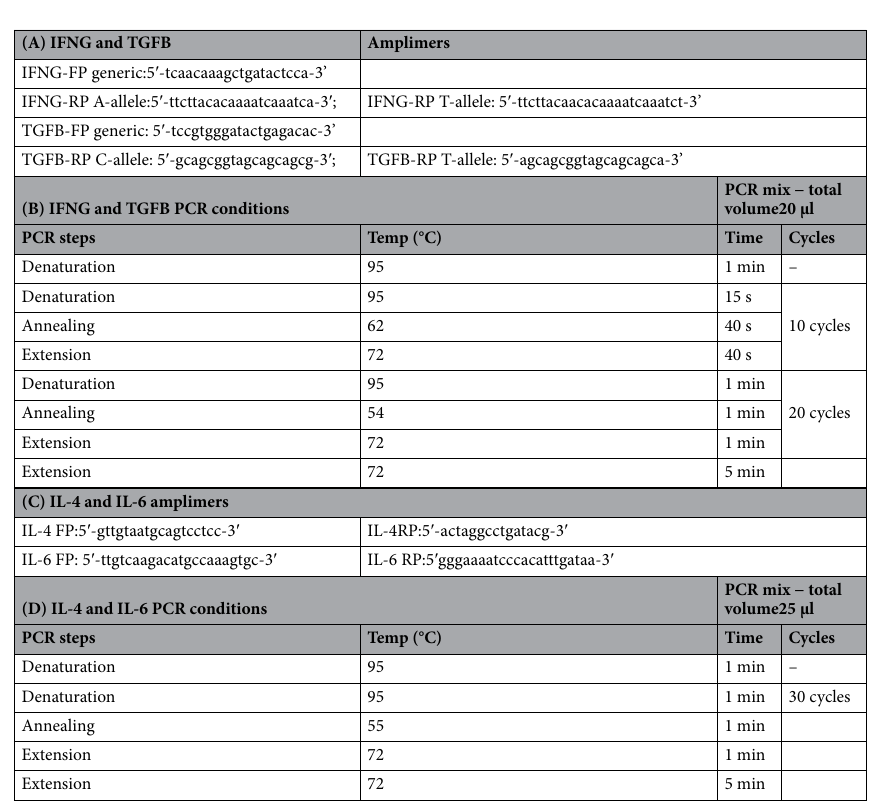
Table 2. Amplimers and PCR conditions. Digestion of IL4 done by BSmFI 65 °C 15 min 0.1 µl of RE and 1 µl cutting buffer for 10 µl PCR sample. Digestion of IL6 done by NIaIII 37 °C 15 min 0.02 µl of RE and 1 µl cutting buffer for 10 µl PCR sample. List of amplimers and PCR conditions used to amplify the promoter cytokines of their